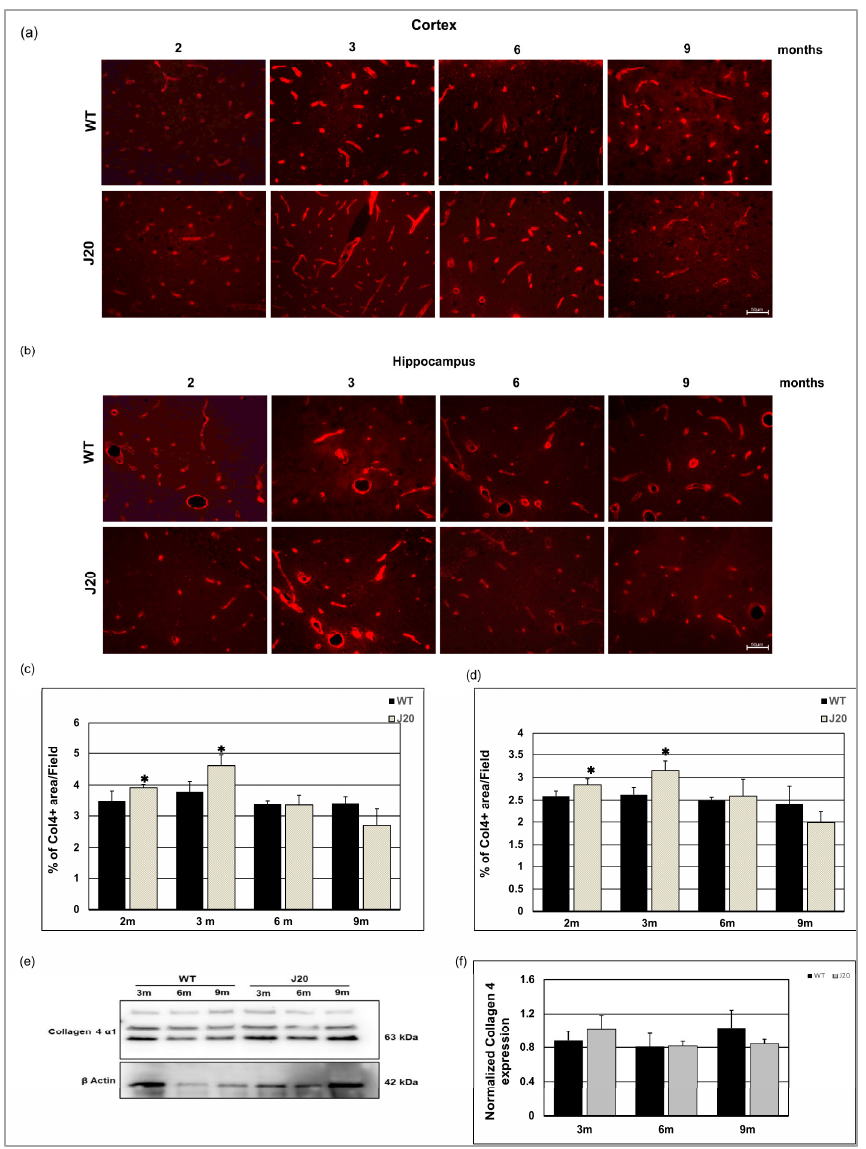
Figure 5. Time-dependent immunoreactivity of collagen 4 in J20 mice brain. Immunoreactivity of collagen 4 in the cortex ( a ) and hippocampus ( b ) of both WT and J20 mice at 2, 3, 6, and 9 months of age. Collagen 4 immunoreactivity was around the vessel in WT and J20 mice brains. Densitometric analysis by ImageJ as a percentage of collagen 4 positive areas per field (×40) in the cortex ( c ) and hippocampus ( d ) shown in the graph. ( e ) A representative immunoblot of collagen 4 protein expression in the hippocampus of WT and J20 mice brains at 3, 6, and 9 months of age. ( f ) Normalized hippocampal collagen 4 expression of different groups at 3, 6, and 9 months. Numerical data are presented here as average ± SD, and statistical significance is denoted as * p < 0.05 vs. age-matched WT. Col4 = Collagen 4. M indicates month. Scale bar = 50 µ